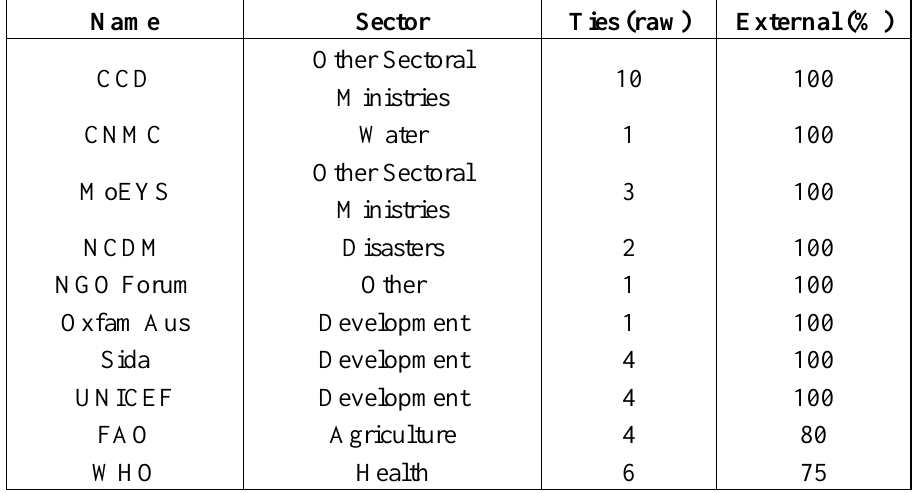
Table 5. External partnerships: Top 10 agencies (% of partnership